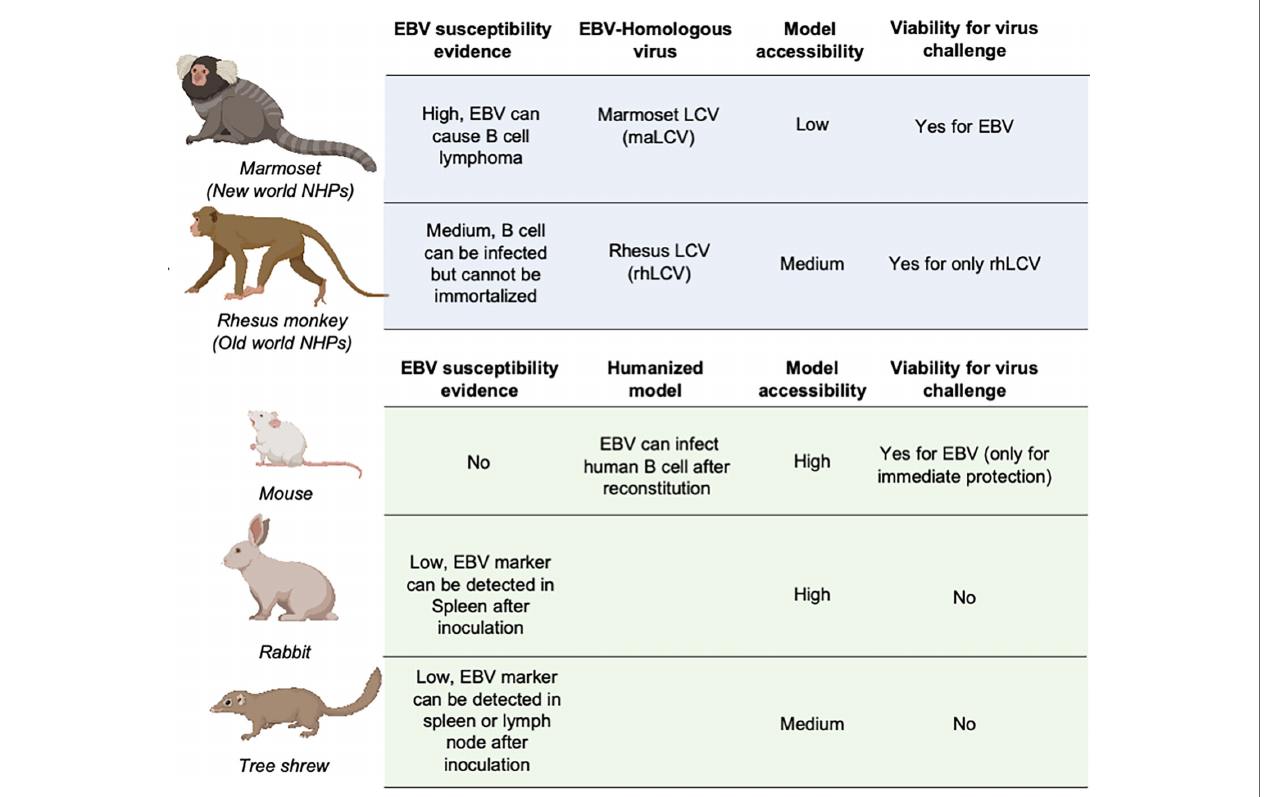
FIGURE 3 | Animal models for EBV vaccine evaluation. Non-human primates are marked in light blue and other animal models are marked in light green. LCV,